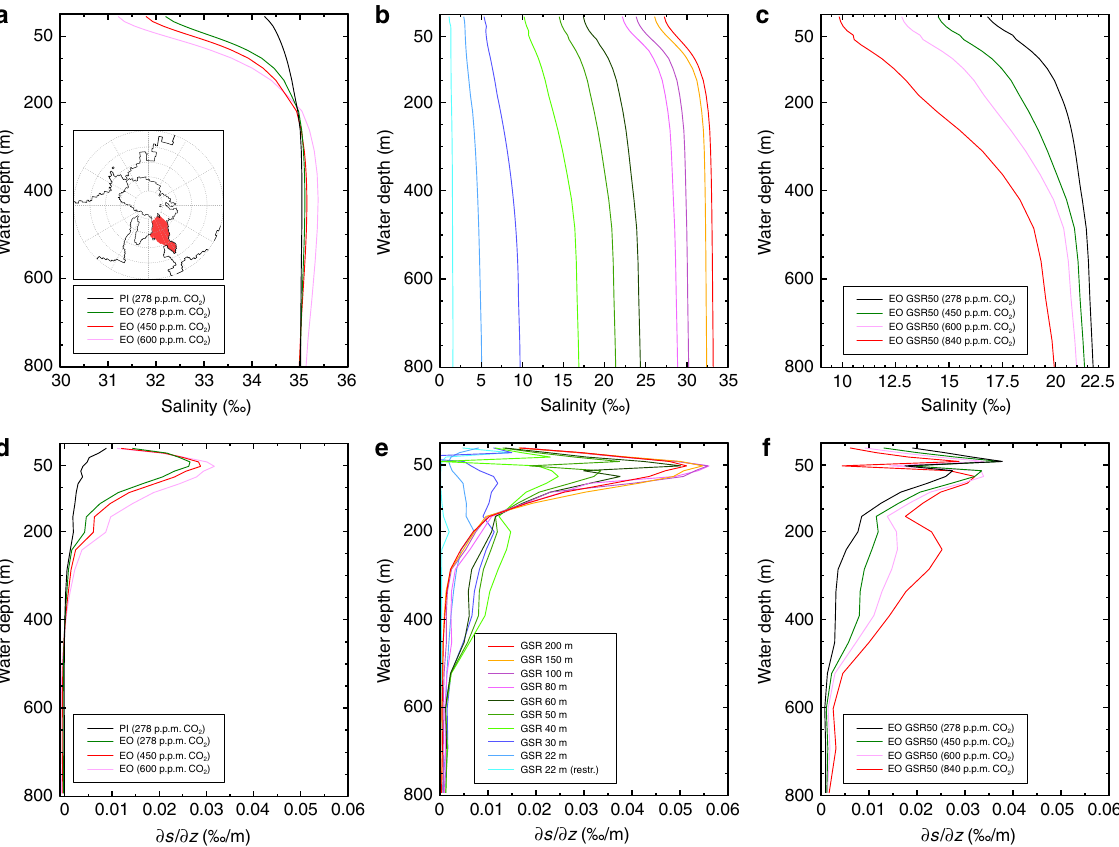
Figure 6 | Impact of atmospheric CO 2 changes and gateway changes on vertical salinity characteristics in the subpolar Arctic. Mean salinity profiles ( % ) and haloclines ( d S / d z ; % /m) of the subpolar Arctic (Greenland and Norwegian Seas) for different atmospheric CO 2 levels ( a , d ), Greenland-Scotland Ridge (GSR) gateway sill depths ( b , e ) and different atmospheric CO 2 levels at limited GSR sill depths of 50metres below sea level ( c , f